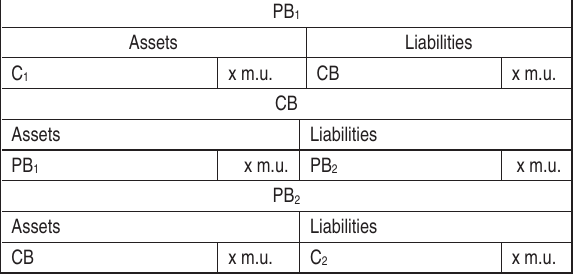
Table 1. The first phase of an interbank payment